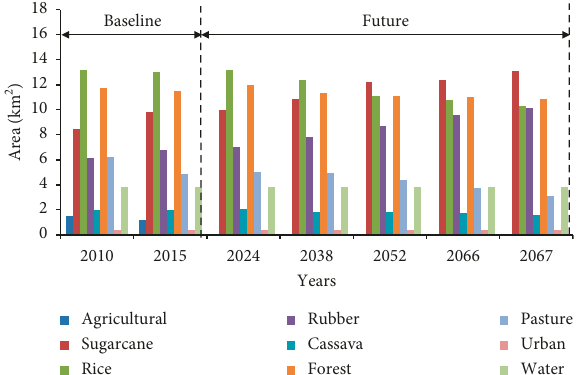
Figure 12: Simulated land use maps for 2018–2067 above the Huay Ling Jone area by participation process.